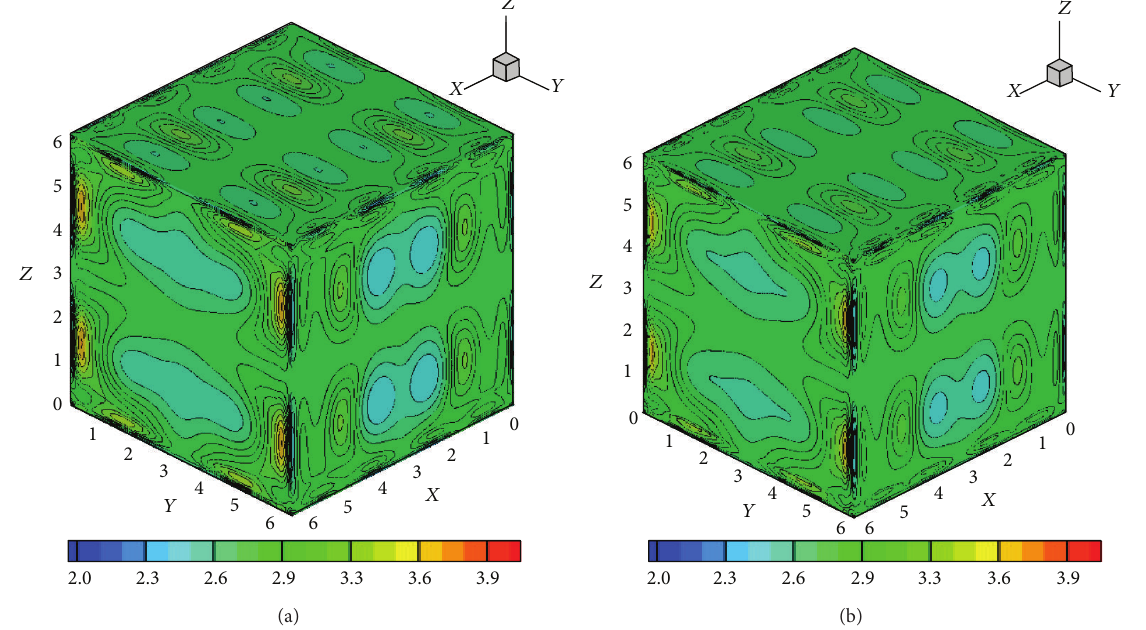
Figure 11: Instantaneous contours of density across 𝑥 -, 𝑦 -, and 𝑧 -direction centerlines ( = 𝜋 ) at 𝑡 = 0.2 for two different grid sizes 128 3 (a) and 256 3 (b).